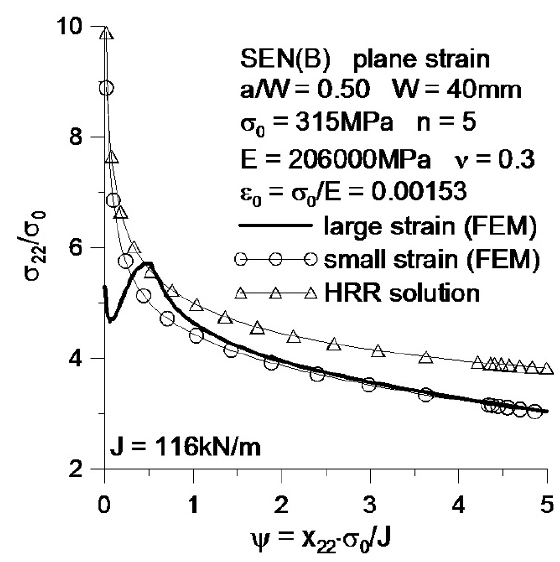
Figure 1. The stress distribution near a crack tip for SEN(B) spec- imen – curves were obtained using the FEM (Finite Ele- ment Method) for small and finite strain and HRR formula (based on [10, 11, 16]) crack when the finite strains are used is not a trivial prob- lem. The level of the stress maximum and its localization depends on the FE mesh details when it is not properly selected. For the small strain option such a problem is not observed [3, 4, 8, 9].